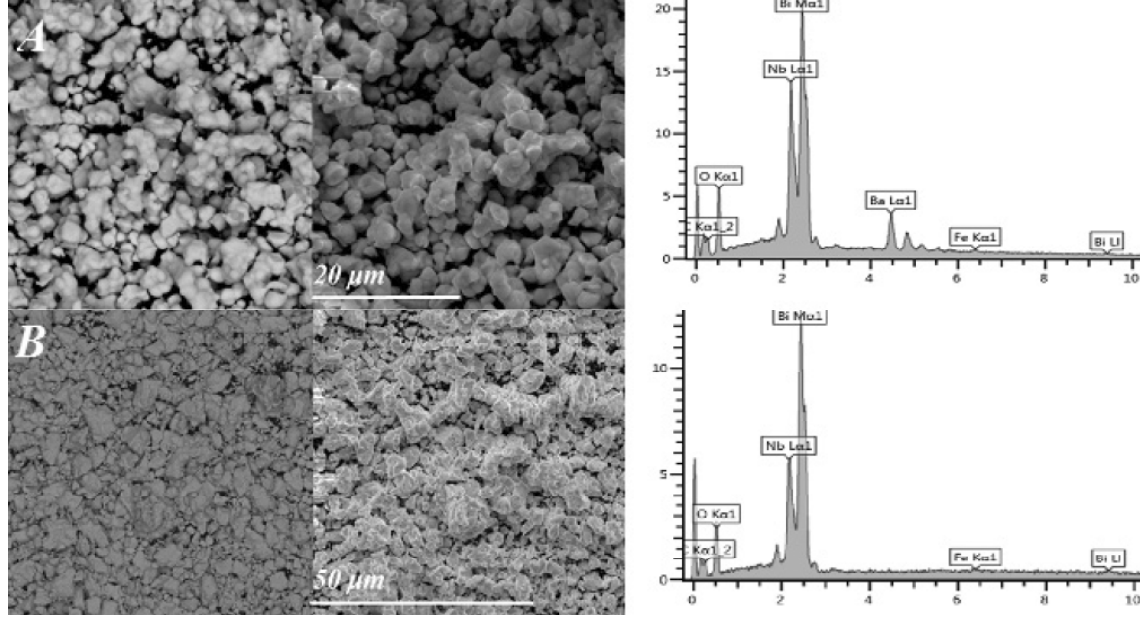
Fig. 2. EDS spectrums and surface photomicrographs of the sample Bi Bi Nb Fe O (b) in the mode of secondary and elastic backscattered electrons. 5 2.82 0.18 15- 